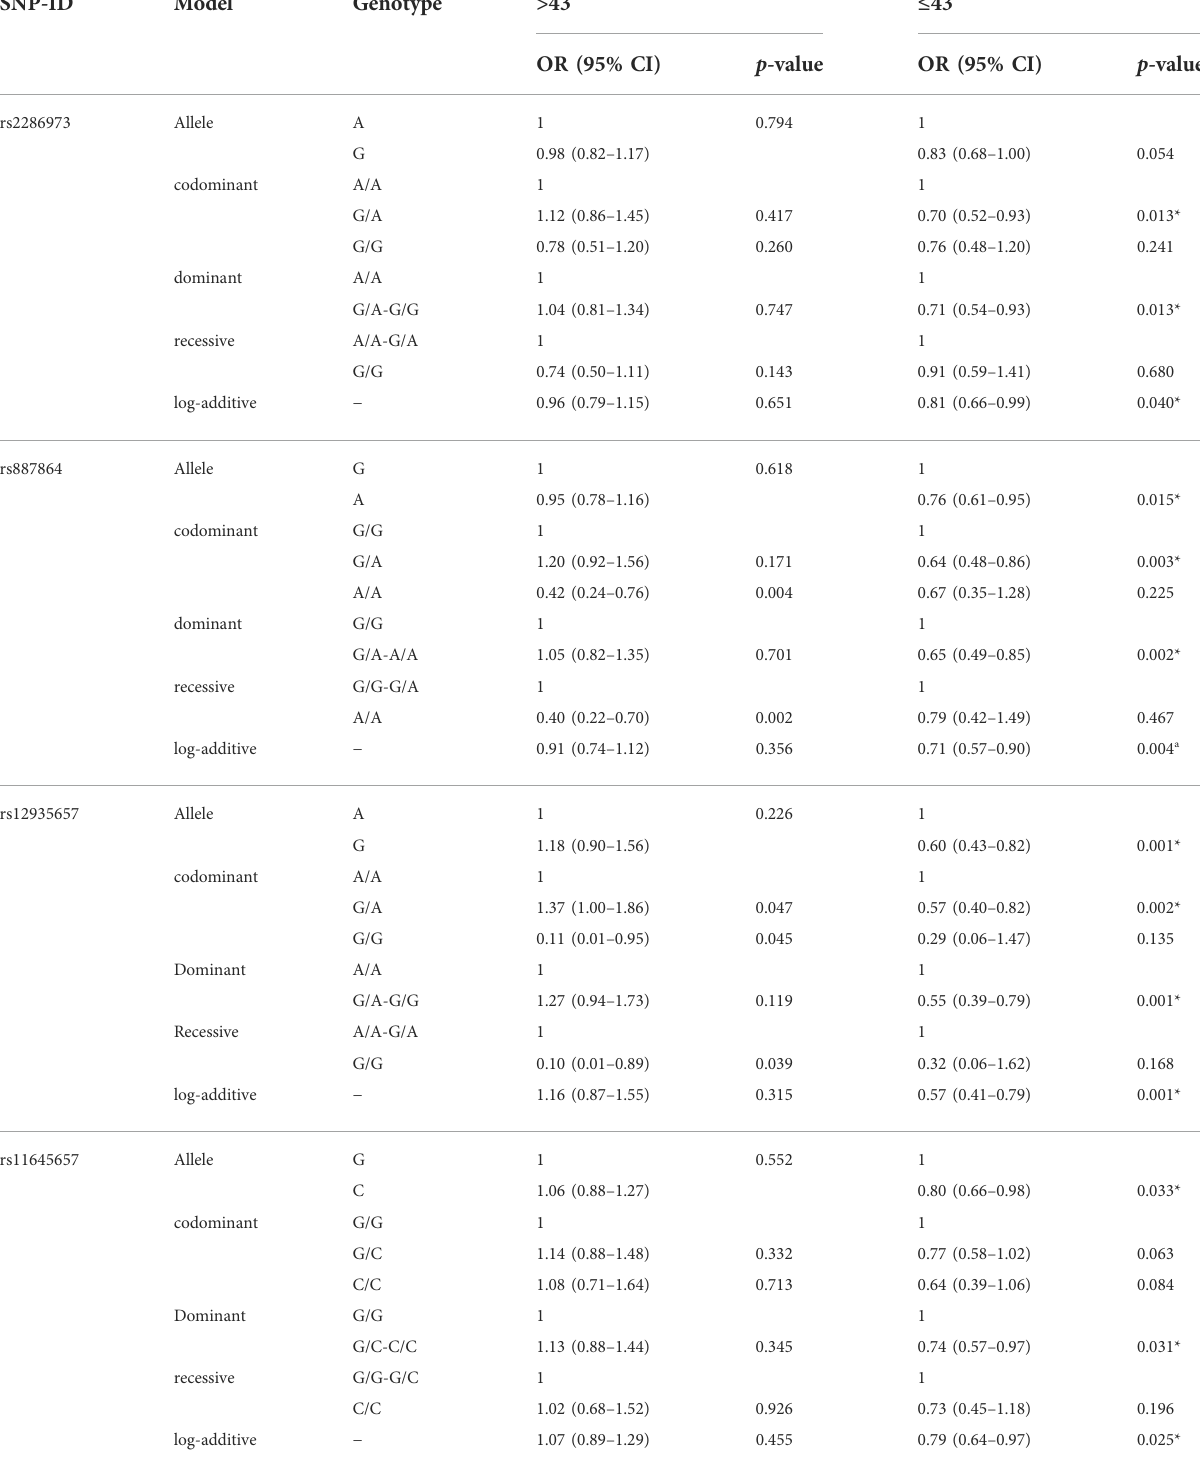
TABLE 4 Association between CLEC16A variants and AR risk strati fi ed by